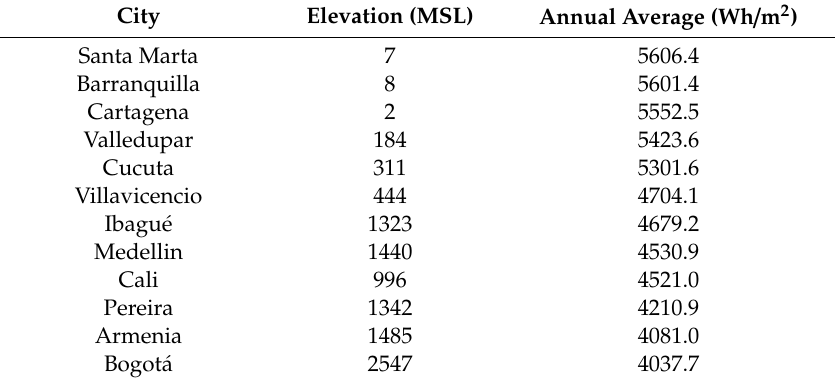
Table 1. Annual global irradiation averages in the largest cities of Colombia [3]. City Elevation